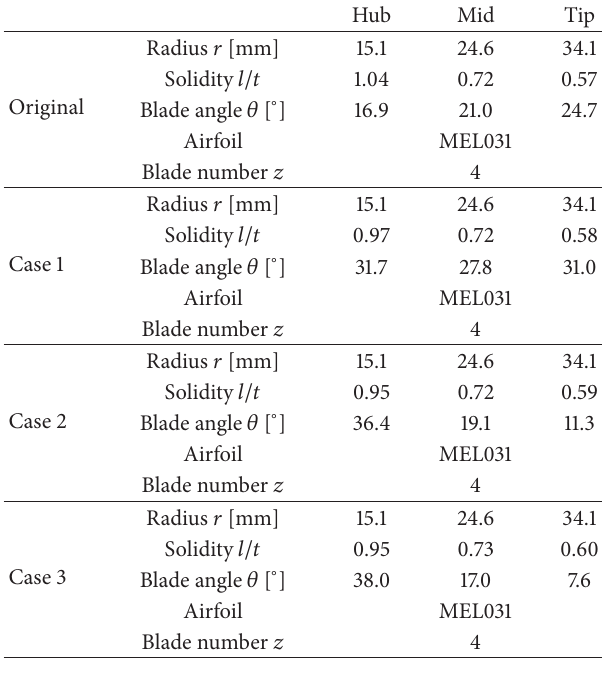
Table 1: Specifications of test runners.